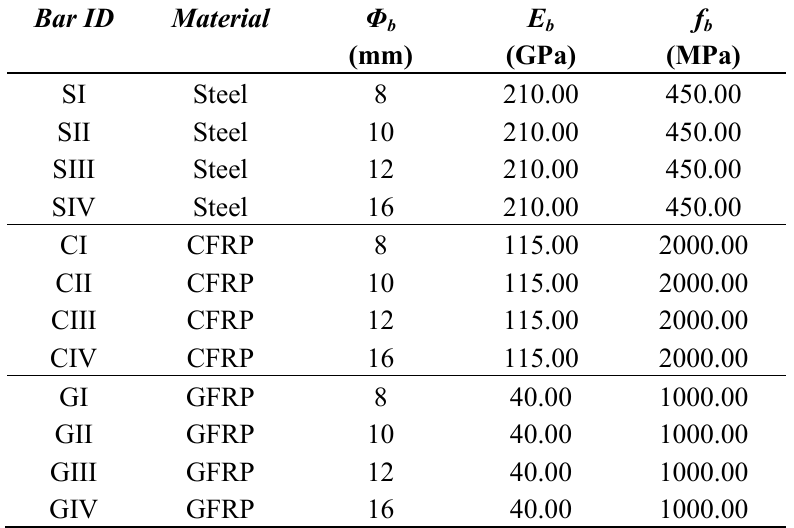
Table 1. Certified geometrical and mechanical properties of the reinforcement bars.